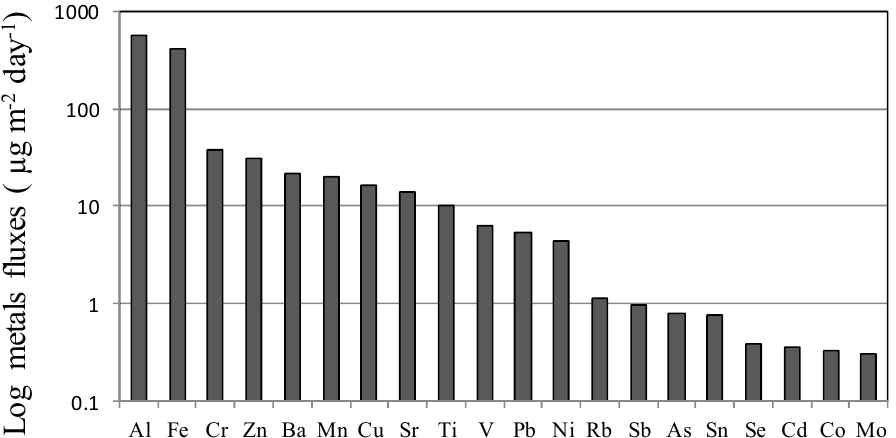
Figure 6. Average daily fluxes of trace elements (µg m −2 day −1 ) in Zagreb (April 2009 to May 2010). We compared our data with literature data using similar sampling procedures. The daily fluxes of Zn, Cu, Mn, Pb, V, and Ni were lower in Zagreb by a factor of about 4, 6, 3, 11, 9, and 7 than those at an industrial site in Belgrade [82] . The comparison was also made with data from the city of